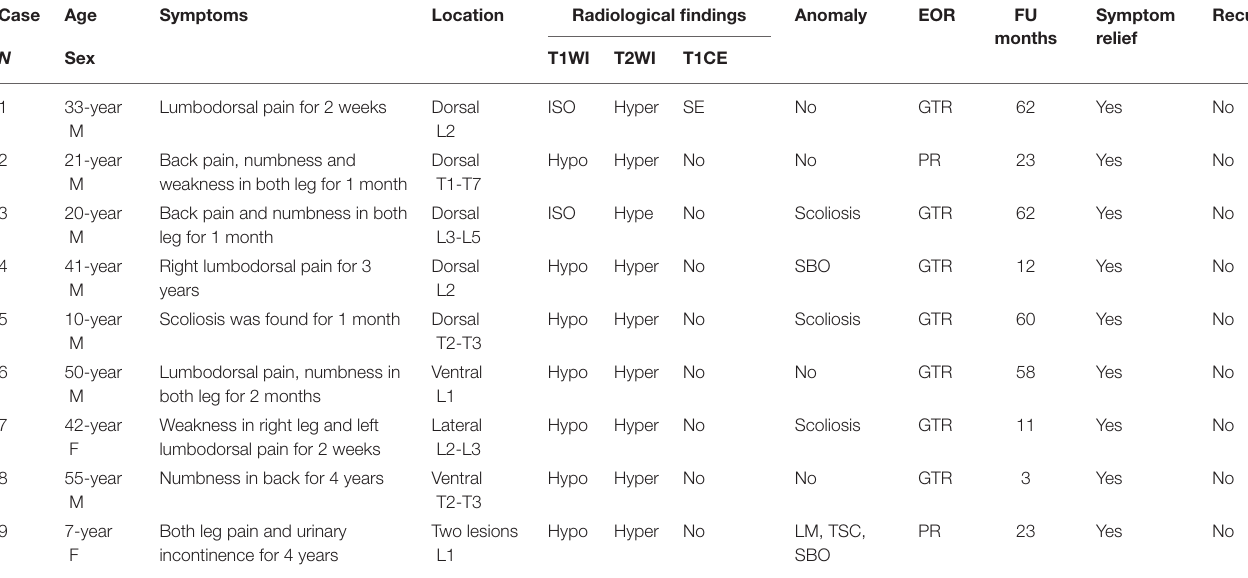
TABLE 1 | Clinical data and outcome of IEBC in our hospital.